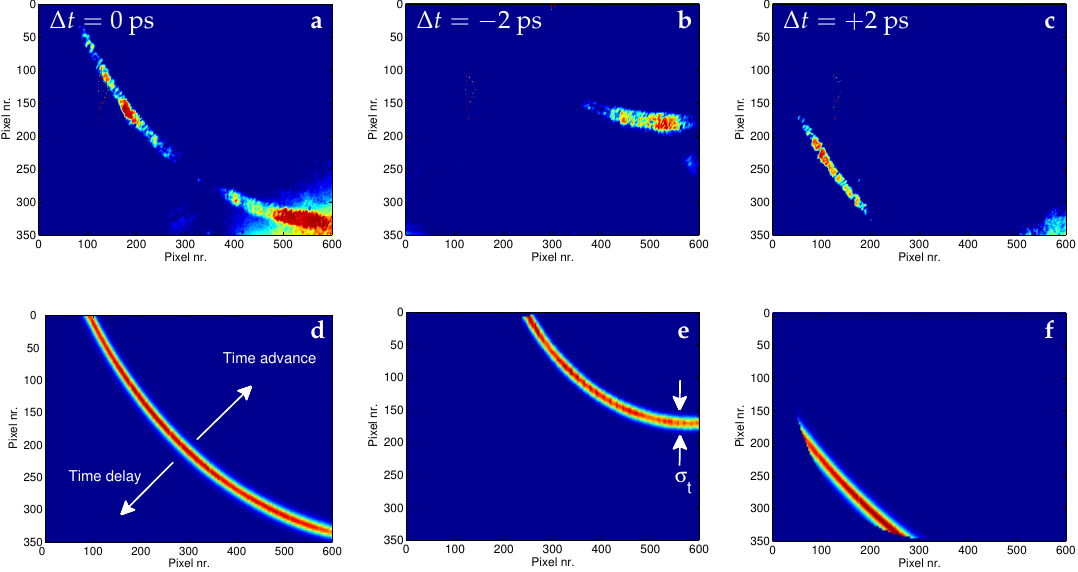
Figure 4. ( a – c ) experimental EOS data obtained by changing the probe laser delay ( ∆ t ) with respect to the main laser. For a delay (advance) of the probe laser, the resulting signals shift down (up); ( d – f ) simulated EOS signals. The time direction is indicated by the white arrows in ( d ). The lack of uniformity in the experimental signals is mainly due to inhomogeneities both on the ZnTe crystal surface and on the transverse profile of the probe laser